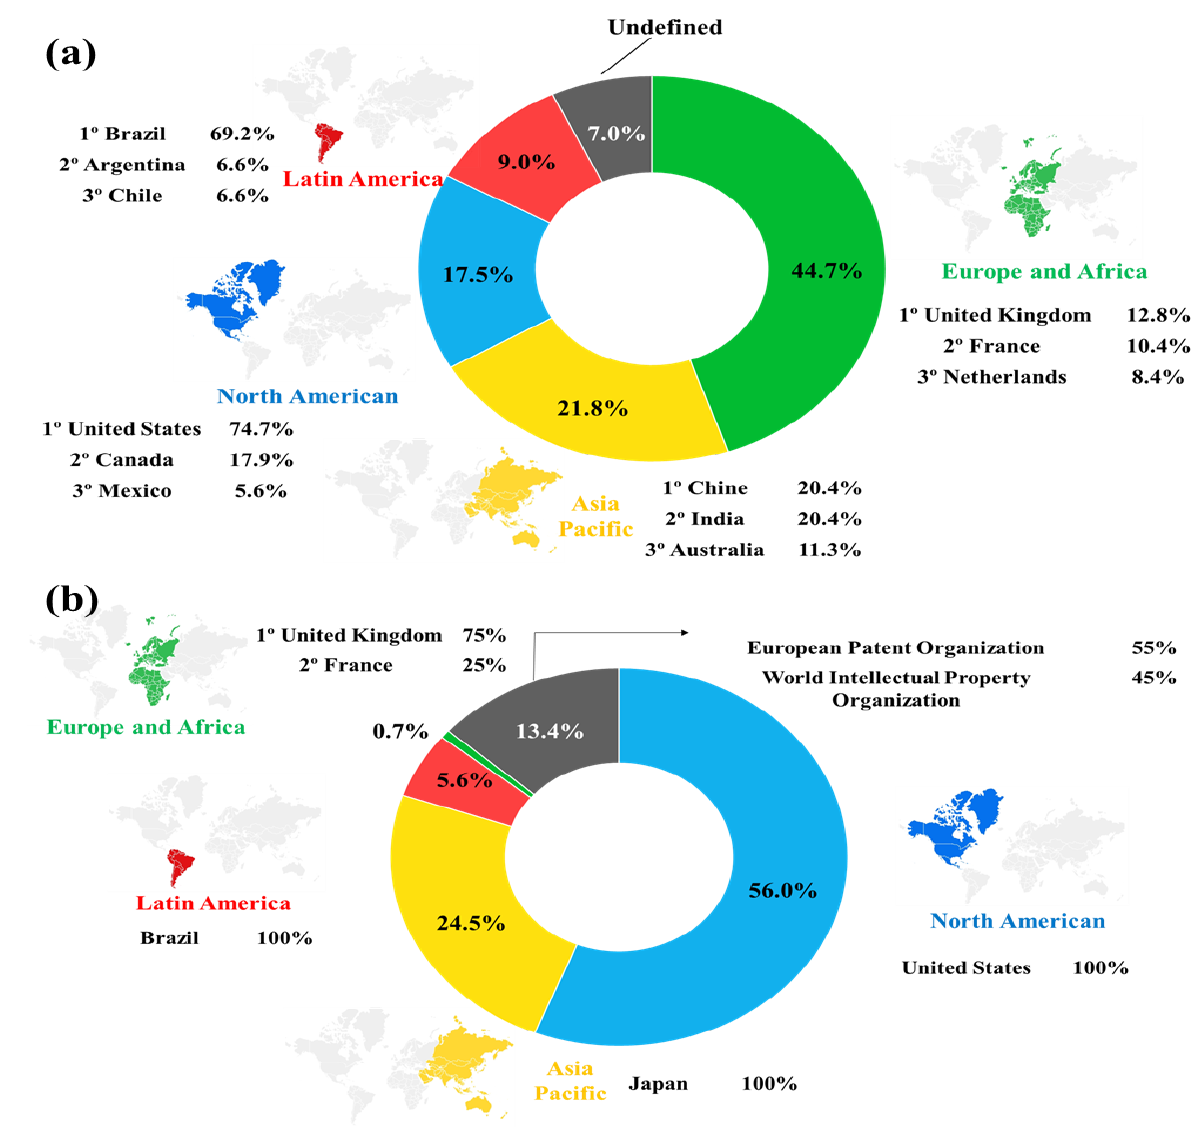
Figure 5. Number of articles published ( a ) and patents deposited ( b ) related to the participation of family farming in the development of food products, according to the country of publication or deposit.